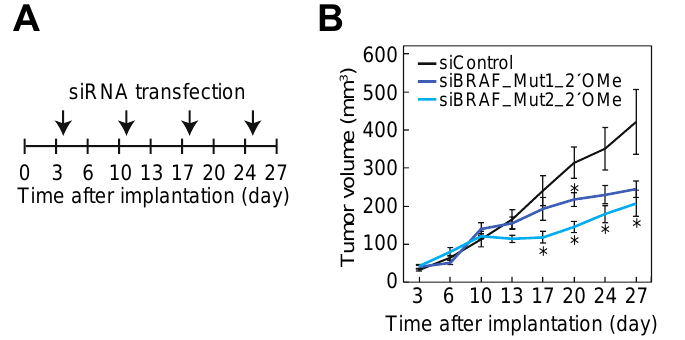
Figure 5. siBRAF suppresses the growth of xenograft tumors. ( A ) Time course of xenograft experiment for the investigation of anti-tumor effects of siBRAF_Mut1_ 2′ -OMe and siBRAF_Mut2_ 2′ -OMe. ( B ) The effect of siBRAF on the tumor growth. Tumor size was measured twice a week, and results are shown as mean with SEM ( n = 5). The results indicate the averages of 5 independent experiments. The p -values were calculated by Student ’ s t -test versus siControl (* p < 0.05).